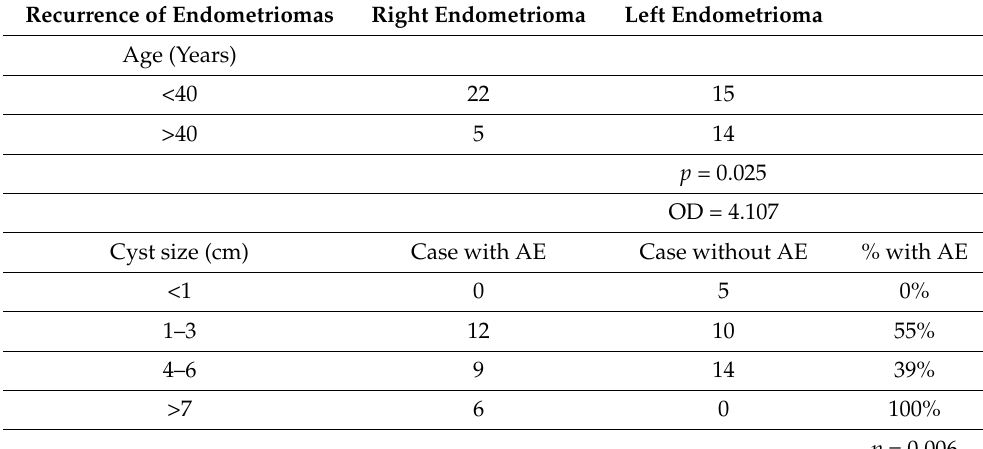
Table 2. Recurrence of endometrioma and endometriotic cysts with and without atypical endometrio- sis (AE).